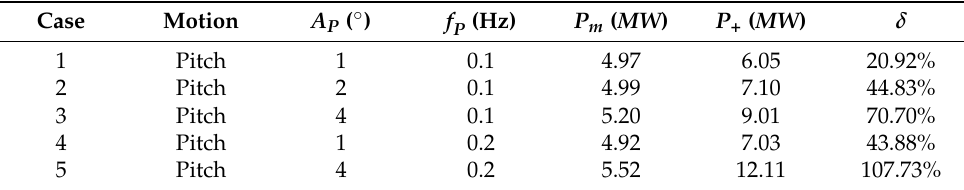
Table 4. Pitch motion cases.